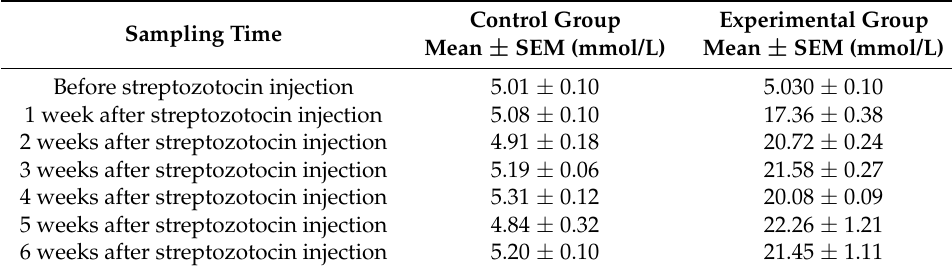
Table 1. Serum glucose levels in pigs of the control and experimental